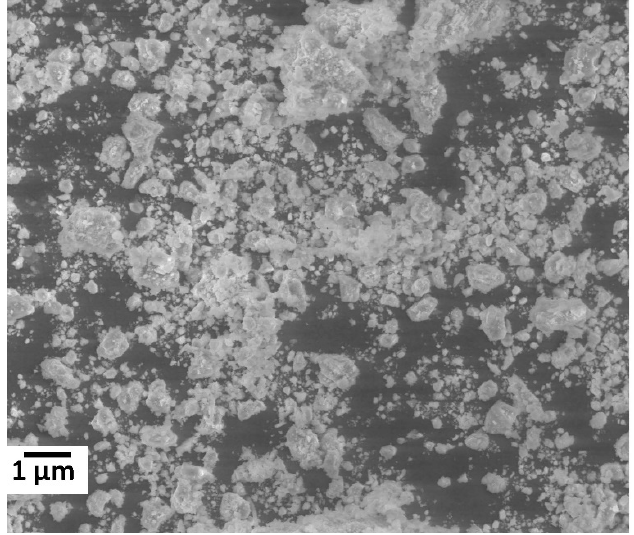
Figure 2. SEM image of Fe 3 O 4 /ITO electrode.